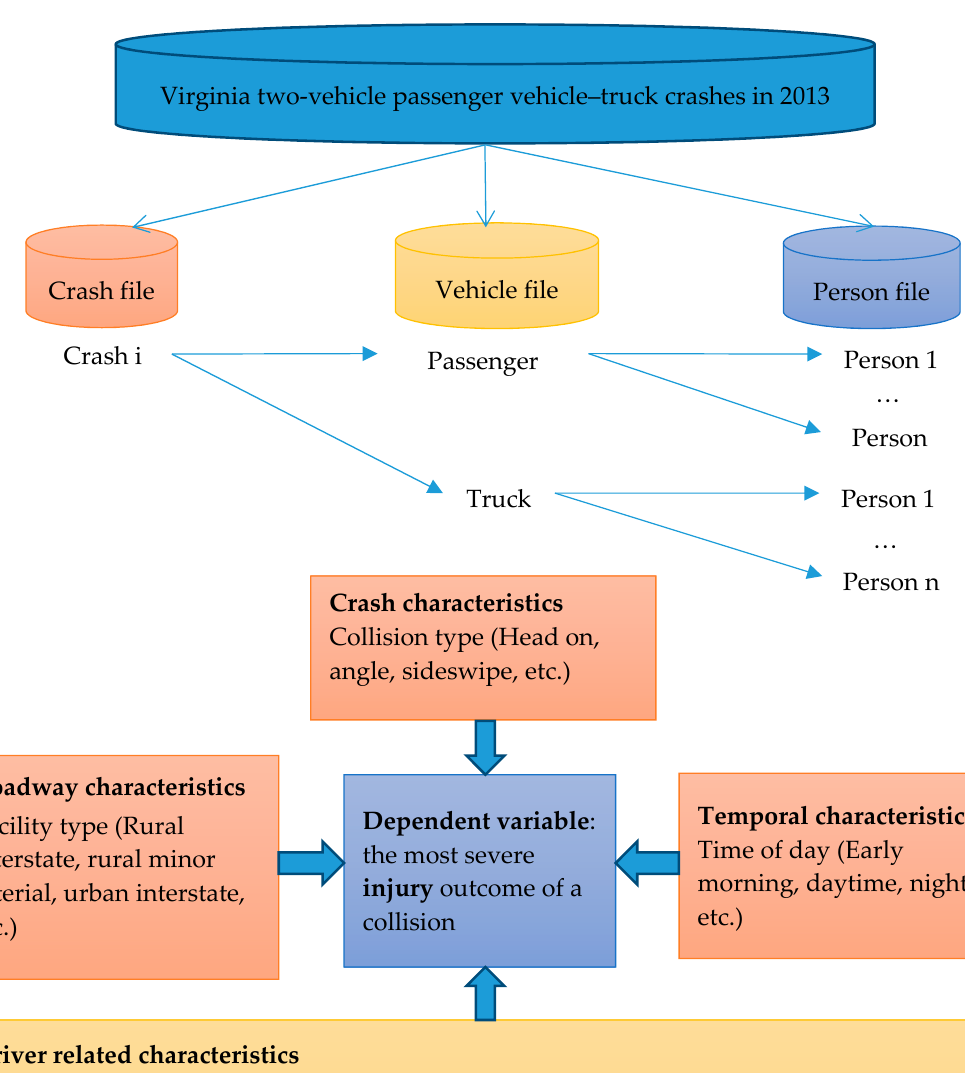
Figure 1. Data structure and conceptual framework.